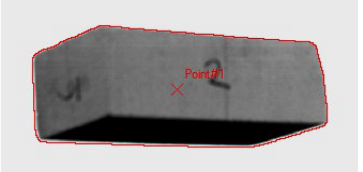
Figure 4. Example of outline tracking (red line) of a brick.